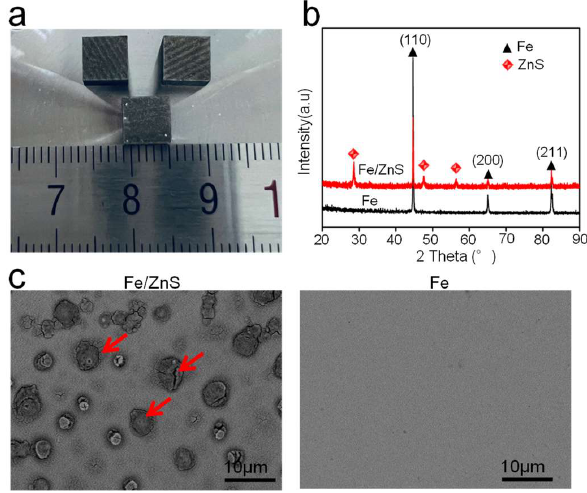
Figure 1. ( a ) LPBF processed Fe-based parts; ( b ) the XRD spectrum and ( c ) SEM for Fe and Fe/ZnS biocomposite showing the microstructure. The ZnS particles were marked by the red arrows.